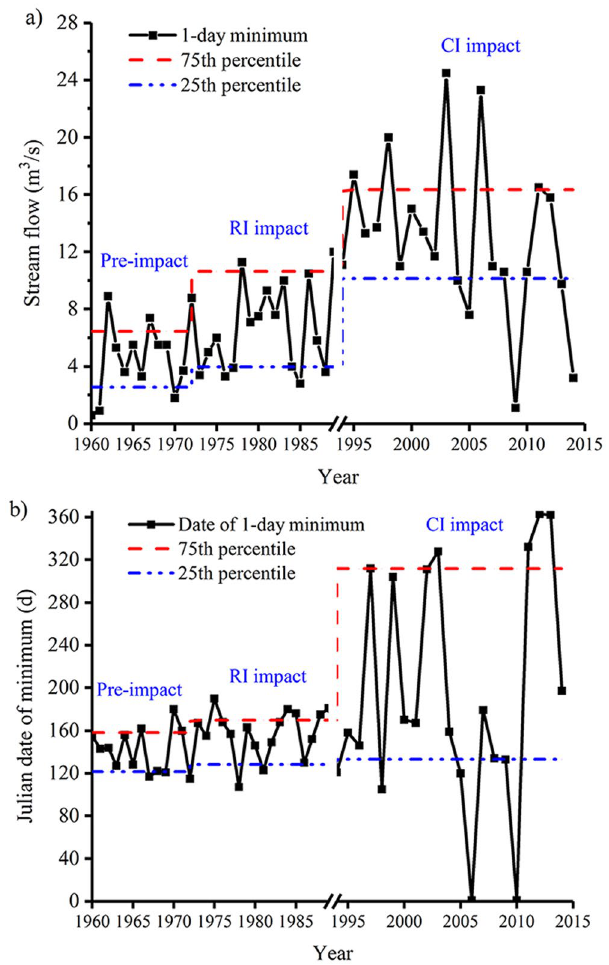
Figure 2. Plots of ( a ) 1-day minimum stream flow and ( b ) Julian date of minimum stream flow occurrence at the Alar